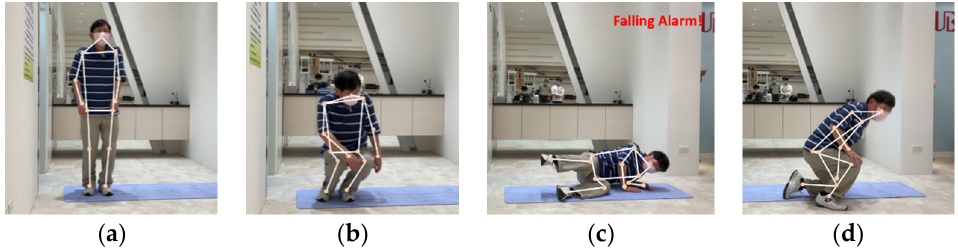
Figure 18. Representative recognition results from the video of a falling elderly man: ( a ) Frame 218 (walking); ( b ) Frame 376 (squatting); ( c ) Frame 423 (falling); ( d ) Frame 823